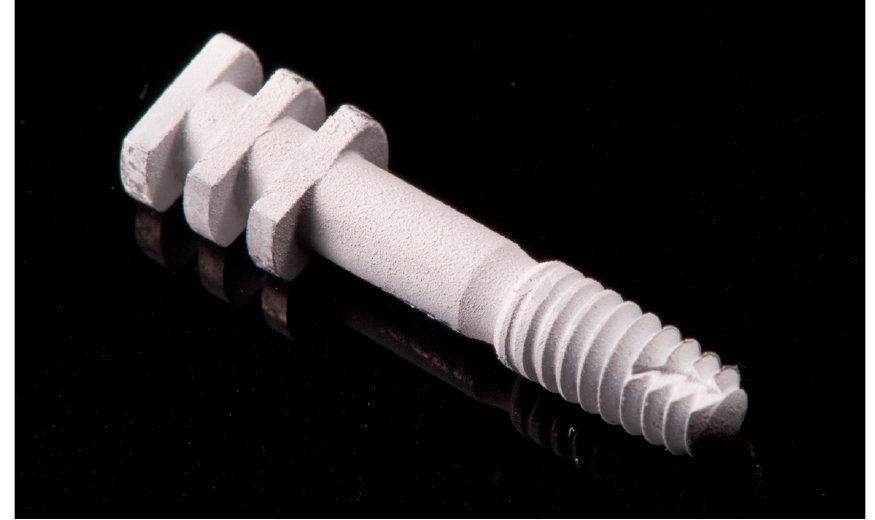
Figure 2. Implant model with an attached closed tray impression transfer prepared for scanning.